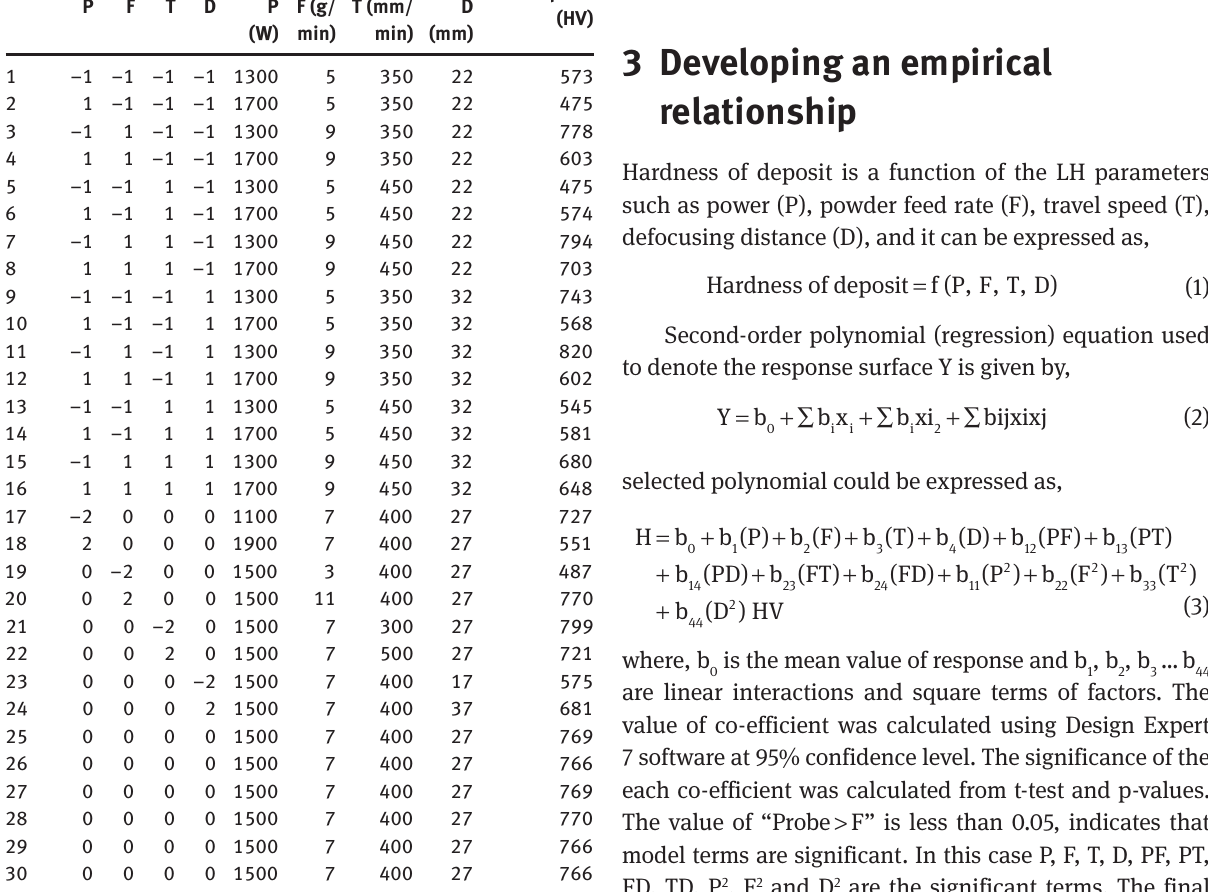
Table 6: Design matrix and experimental results. Expt. Figure 3: Laser hardfaced